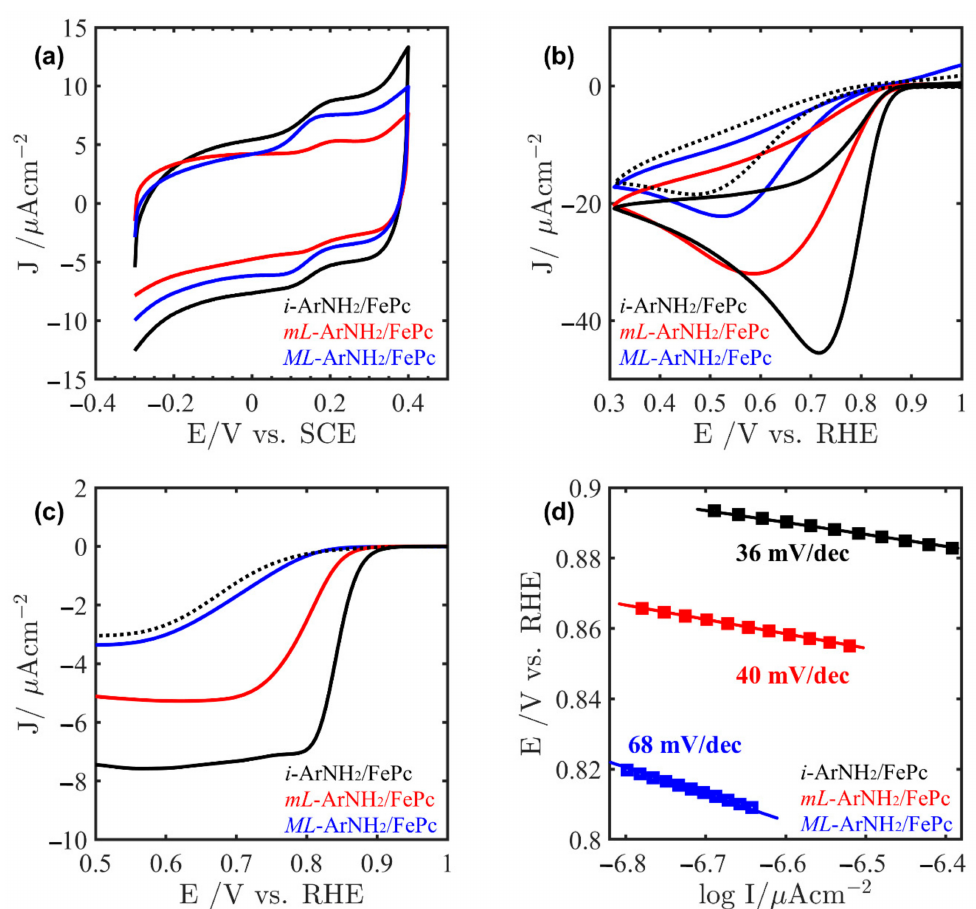
Figure 5. ( a ) Electrochemical characterization by cyclic voltammetry of modified electrodes: Au/ i -ArNH 2 /FePc (black), Au/ mL -ArNH 2 /FePc (red), and Au/ ML -ArNH 2 /FePc (blue) in N 2 -saturated Britton–Robinson buffer (pH: 3) at 50 mV s − 1 ; ( b ) electroreduction of O 2 on bare Au electrode (dotted line) and modified electrodes in 0.1 M NaOH at 50 mV s − 1 in saturated O 2 ; ( c ) polarization curves by linear sweep voltammetry of modified electrode: i -ArNH 2 /FePc (black), mL - ArNH 2 /FePc (red) and ML -ArNH 2 /FePc (blue) in 0.1 M NaOH at 1mV s − 1 in saturated O 2 ; ( d ) Tafel